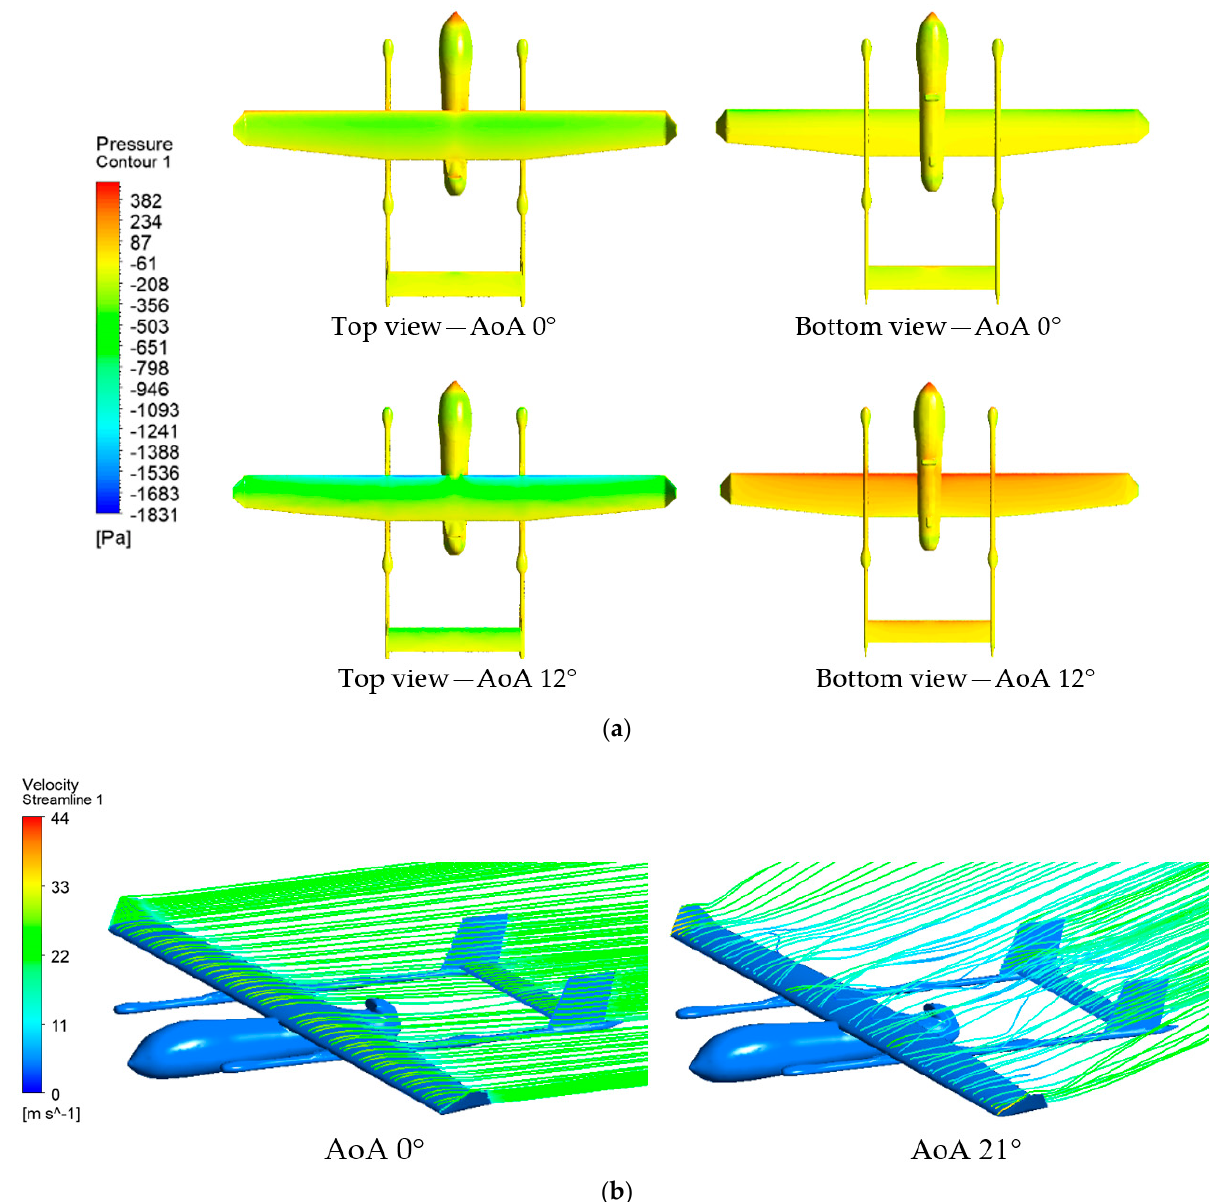
Figure 9. Lift, drag, and stall phenomena, ( a ) lifting and drag phenomena and ( b ) stall